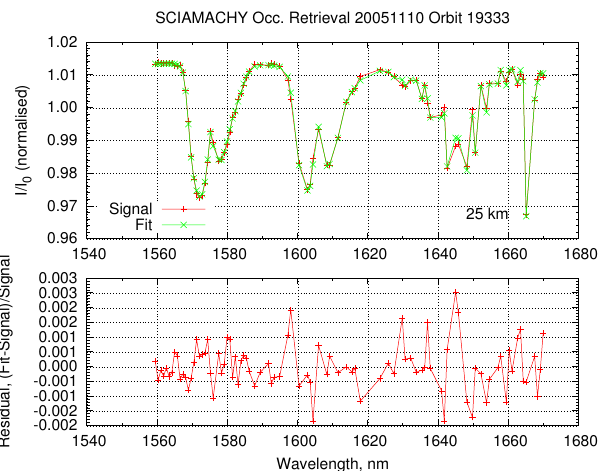
Figure 3. Example of a spectral fit. Top: normalised measured spec- trum (red) and fitted spectrum (green) at 25km tangent altitude. Bottom: resulting residual, i.e. relative difference between measure- ment and